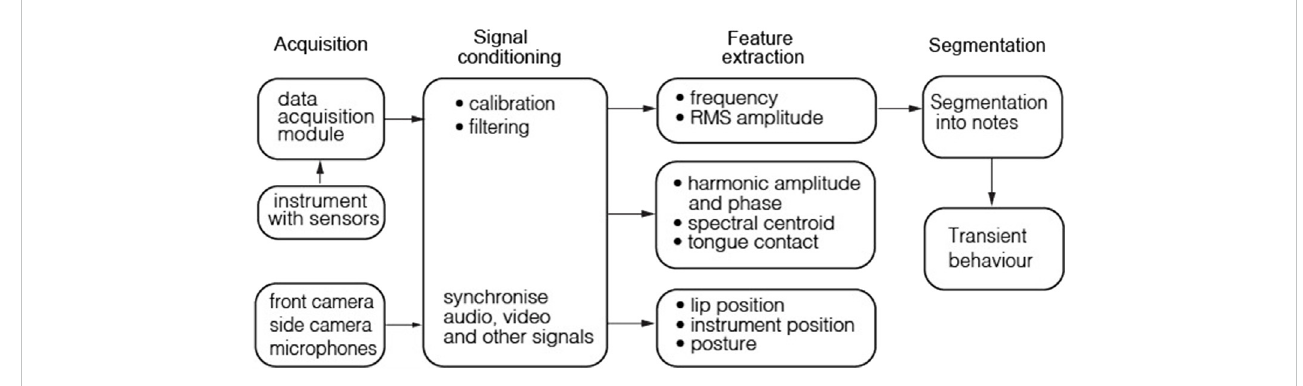
FIGURE 5 Flowchart of the software processing applied to the signals by MIPCAT. Acquired signals go through some pre-processing steps (conditioning), are processed to extract time-series of low-level sound features and are then segmented into notes and sub-segmented into transient and sustained